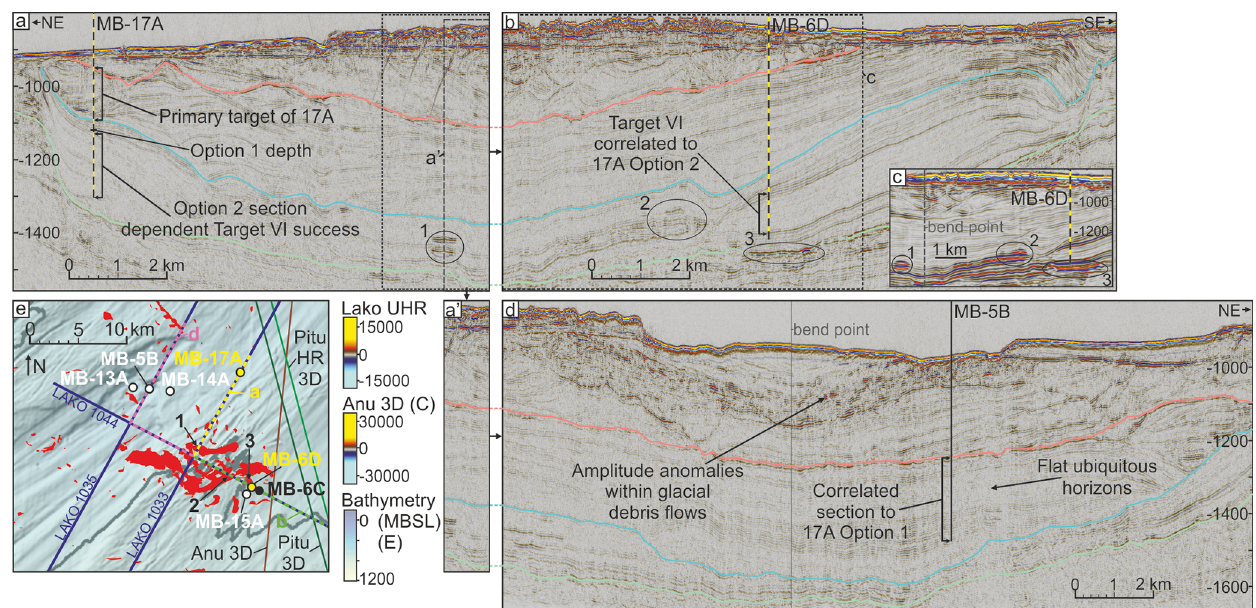
Figure 12. Target V. (a) A seismic cross section from the LAKO UHR survey showing the location of primary site MB-17A. Both depth options for this site are shown along with horizon interpretations (coloured) that were mapped throughout the area to allow the correlation of target stratigraphy with the other sites. The section of seismic that represents panel (a’) is also shown, with panel (a’) displayed beneath, next to panel (d) , to show how both the seismic lines in panels (b) and (d) are connected to the seismic line of panel (a) . (b) A LAKO UHR seismic cross section displaying the stratigraphic correlation between sites MB-17A and MB-6D. (c) A seismic cross section from the Anu survey shown for comparison between the two surveys. Fluid anomalies are shown and numbered and their appearance can be compared with the associated anomalies displayed in the LAKO UHR survey in both panels (a) and (b) . The location of panel (c) is also shown in both panels (a) and (b) . (d) A LAKO UHR seismic cross section displaying the stratigraphic correlation between sites MB-17A and MB-5B. (e) A location map for the seismic lines used in panels (a) , (b) and (d) that represents an enlarged section of Fig. 3 displaying the regional bathymetry from Newton et al. (2017) as well as the location of seismic data and mapped seismic fluid anomalies (red). The locations of the seismic anomalies that are highlighted and numbered in panel (c) are also shown. The location of panel (e) is shown in Fig. 3. Uninterpreted versions of panels (a) , (b) and (d) are provided in Fig.